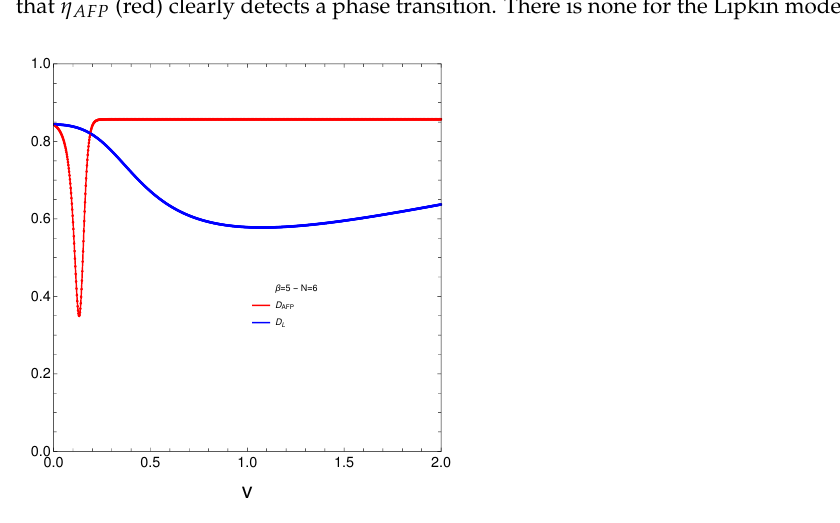
Figure 2. Vertical axis: D AFP (red) and Lipkin’s D L (blue) versus v (horizontal axis). The remaining details are as in Figure